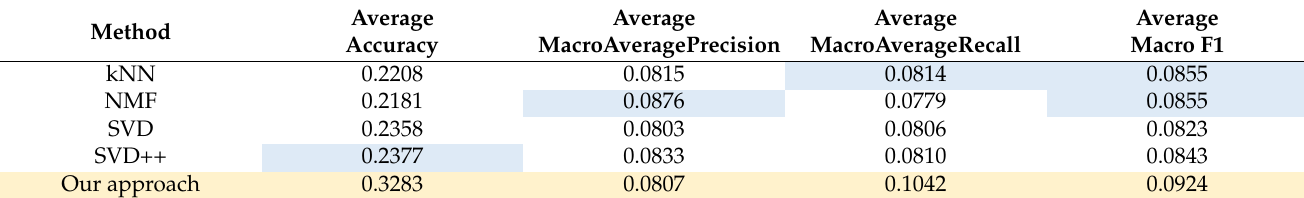
Table 8. Comparison of our proposed approach with other approaches in Experiment 1.